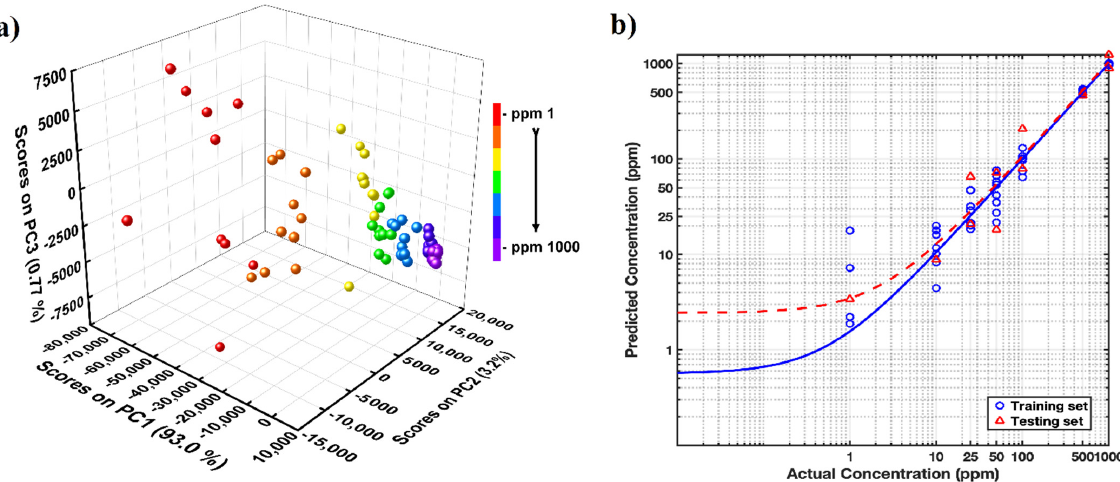
Figure 4. ( a ) PCA Scatter plot for different concentrations of DA; ( b ) PCA − PLSR calibration curves used for DA quantification from spiked DA water.